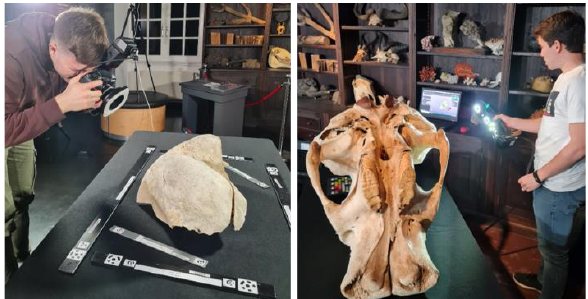
Figure 4. Data acquisition SfM (left) and hand-held scanning system Creafom GO!Scan (right).